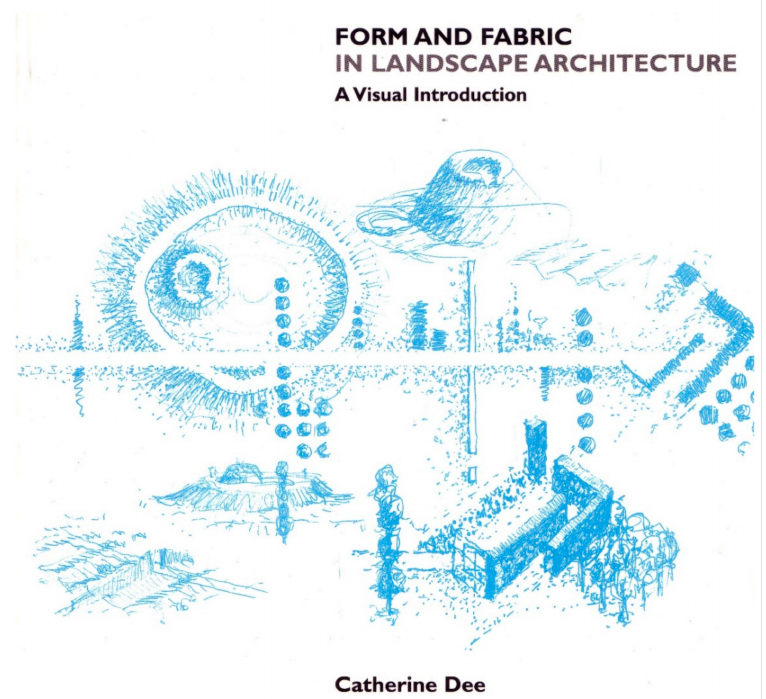
Figure 6. For teaching the visual analysis of the form of the landscape, Cathy Dee, who teaches landscape architecture in Sheffield, UK, is one of the most experienced teachers in the field. Next to her inspirational form of teaching, her specific didactic approach of stimulating students in their drawing is part of achieving this quality in teaching